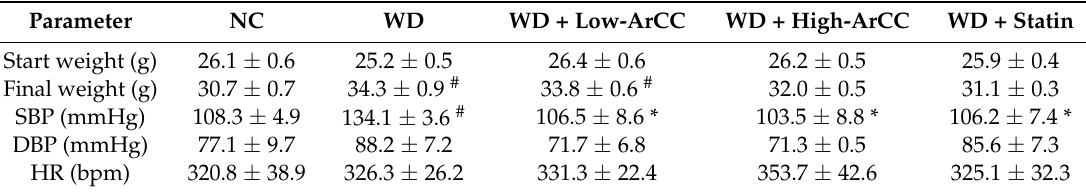
Table 1. Body weight and hemodynamic changes in ApoE − / − mice after 12 weeks of ArCC administration.